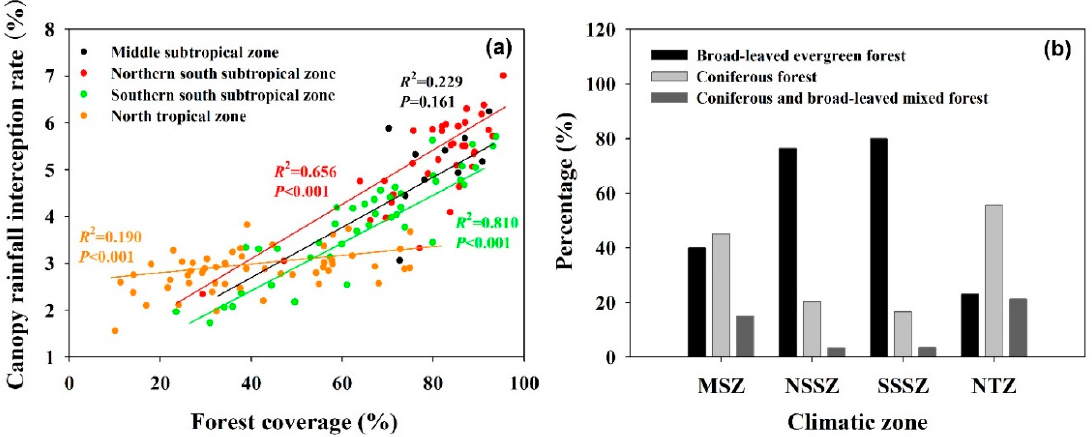
Figure 13. The relationship between the CRIR and forest coverage of all integrated basins in the four climatic zones ( a ), and the percentage of forest types in different climatic zones ( b ). MSZ: Middle subtropical zone, NSSZ: Northern south subtropical zone, SSSZ: Southern south subtropical zone, NTZ: North tropical zone